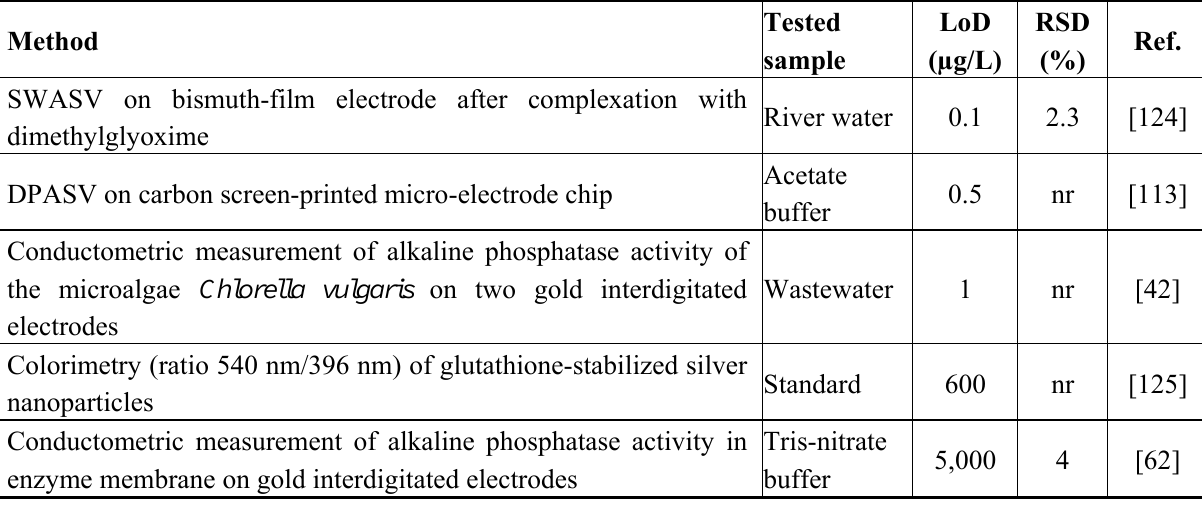
Table 7. Analytical characteristics of sensors for nickel determination in water published between 2007 and